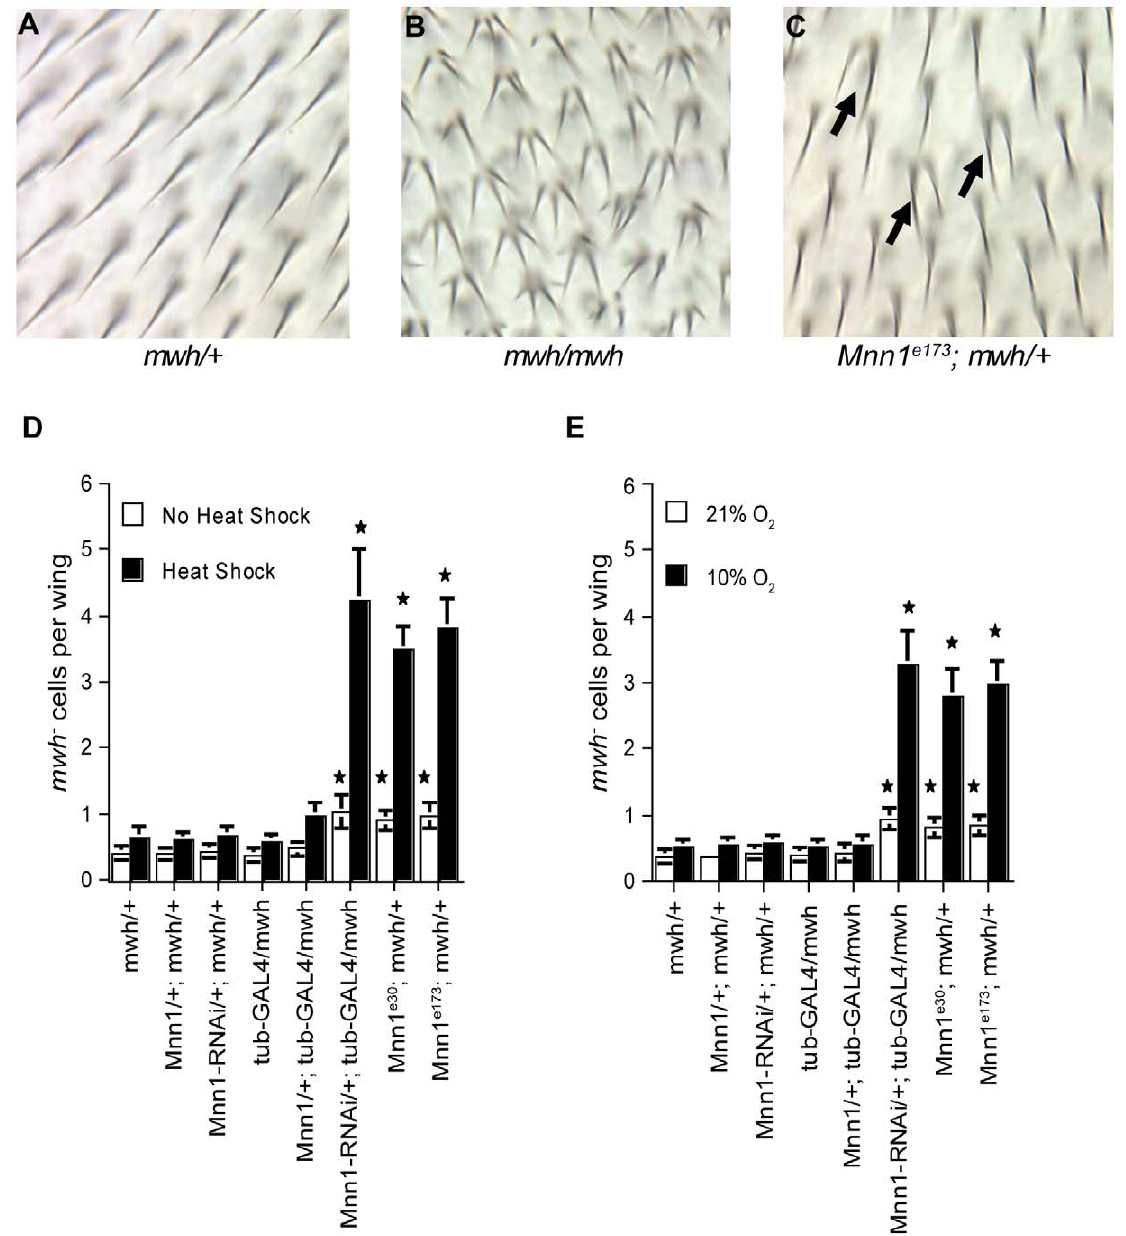
Figure 1. Elevated rates of spontaneous and stress-induced loss-of-heterozygosity in Mnn1 RNA i and deletion mutants. A loss-of- heterozygosity (LOH) assay based on mutations in the multiple wing hairs ( mwh ) gene was used to assess genomic instability in Mnn1 transgenic strains and deletion mutants. ( A ) A fly heterozygous for mwh has one wing hair per cell. ( B ) A fly homozygous for mwh has two or more hairs per cell. ( C ) LOH is elevated in Mnn1 e173 deletion mutant flies. Individual cells that have lost the wild-type mwh gene are observed within a field of heterozygous cells (arrows in C ). Panels A & C show individuals that have received short, repeated heat shock treatments. ( D&E ) In the absence of stress, the incidence of mwh - cells is increased significantly in Mnn1 deletion mutants ( Mnn1 e30 ;mwh/ + and Mnn1 e173 ;mwh/ + ) and flies expressing the UAS construct for Mnn1 RNAi under the control of tubulin-GAL4 ( Mnn1-RNAi/ + ; tub-GAL4/mwh ) (p , 0.05). These elevated rates of LOH are significantly enhanced by short (20 min), repeated heat shock treatments ( D ) and by short (1 hr), repeated hypoxia treatments ( E ). Mnn1 / + ; tub - GAL4 / mwh refers to a strain harboring a UAS construct for menin over-expression; this strain does not show a significant difference in the frequency of LOH. The average number of mwh - cells per wing is indicated. Error bars represent standard errors of the mean (SEM). Stars denote significant differences compared to wild-type controls ( mwh / + ) of the same condition, p , 0.05. doi:10.1371/journal.pone.0014049.g001 Similar experiments were carried out to determine if the lack of significant degree of lethality in normal growth conditions. This lethality was also enhanced by heat shock, thus precluding the p53 function alters the response of Mnn1 null mutants to heat shock. However, unlike embryos expressing the dominant negative analysis of the role of p53 in the lethality caused by Mnn1 mis- form of Chk2 ( mnk ), p53 null embryos were characterized by a expression and stress (our unpublished results).